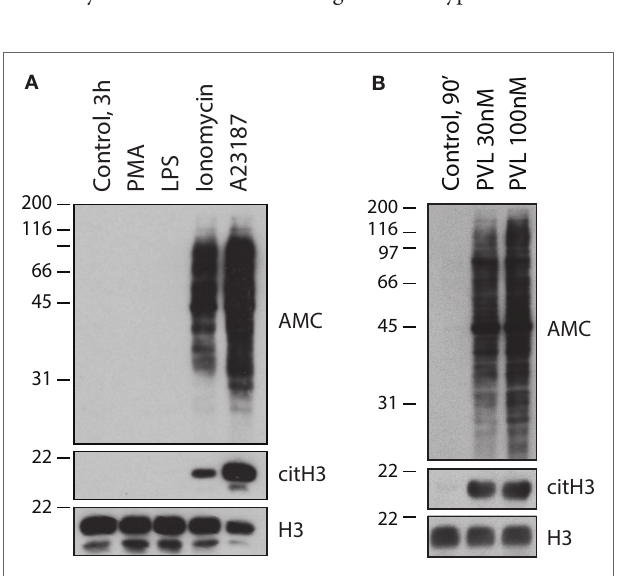
FigUre 2 | Calcium ionophores and the pore-forming toxin pVL from S. aureus , but not netosis-inducing stimuli, activate cellular hypercitrullination in neutrophils . Purified human neutrophils in HBSS/10 mM Hepes/1.5 mM CaCl 2 were incubated (a) in the absence or presence of 100 nM PMA, 500 ng/mL LPS, 1 μ M ionomycin, or 5 μ M A23187 at 37°C for 3 h, or (B) in the absence or presence of PLV from S. aureus (recombinant LukS and LukF from IBT BioServices) at 30 or 100 nM for 90 min at 37°C. Total citrullinated proteins (AMC), citrullinated histone H3 (citH3), and histone H3 (H3) (loading control) were detected by immunoblotting. The experiments were performed on at least two separate occasions with similar